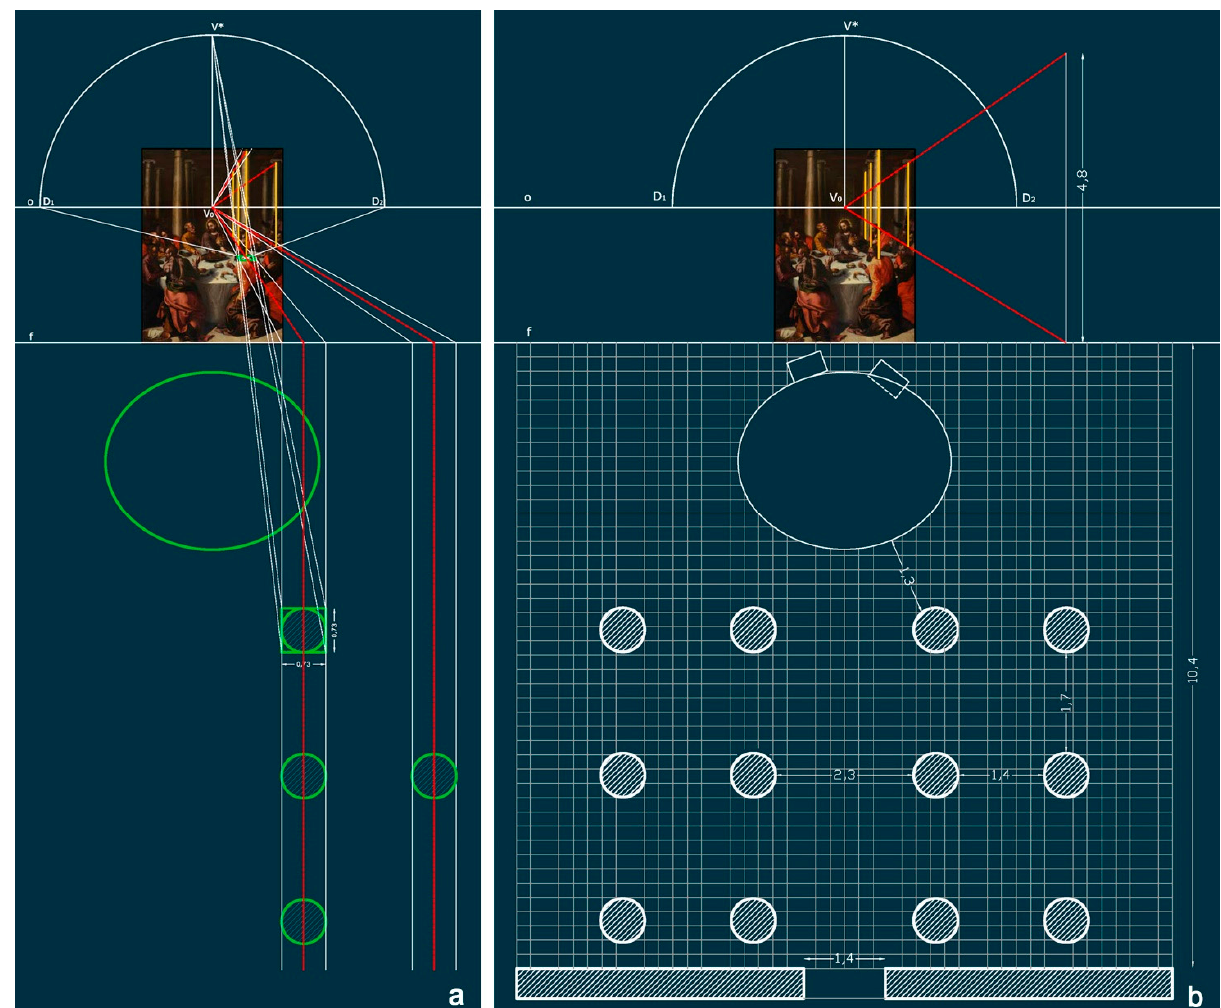
Figure 8. ( a ) Return of the columns; ( b ) overturned plan of the architectural elements